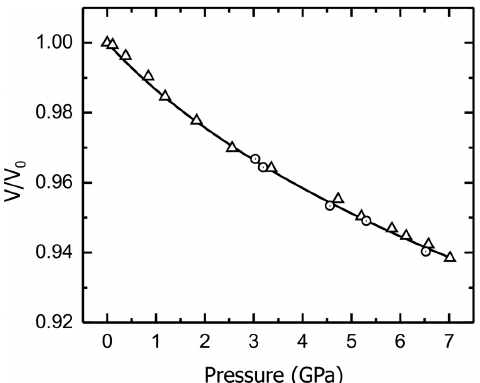
Figure 5. A Birch-Murnaghan fit is shown for the pressure dependence of the experimentally-obtained relative volumes of Ba 8 Cu 13.1 Zn 3.3 P 29.6 . Compression data: triangles; decompression data: circles.